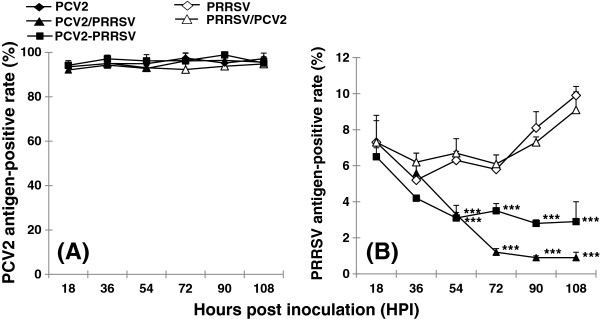
Changes in PCV2 and PRRSV antigen-positive rate in swine alveolar macrophages (AMs). Changes in (A) PCV2 and (B) PRRSV antigen-positive rate in PCV2- and/or PRRSV-inoculated swine alveolar macrophages (AMs) were determined by indirect immunofluorescence assay. Data are expressed as percentage and shown as mean ± SD of three independent experiments. Solid diamond: inoculation with PCV2 alone (PCV2); open diamond: inoculation with PRRSV alone (PRRSV); solid square: inoculation with PCV2 and PRRSV simultaneously (PCV2-PRRSV); solid triangle: inoculation with PCV2 for 18 h first then PRRSV later (PCV2/PRRSV); open triangle: inoculation with PRRSV for 18 h first then PCV2 later (PRRSV/PCV2). *** (P < 0.001) The values are significantly different from PRRSV or PRRSV/PCV2 at the same h post PRRSV inoculation.